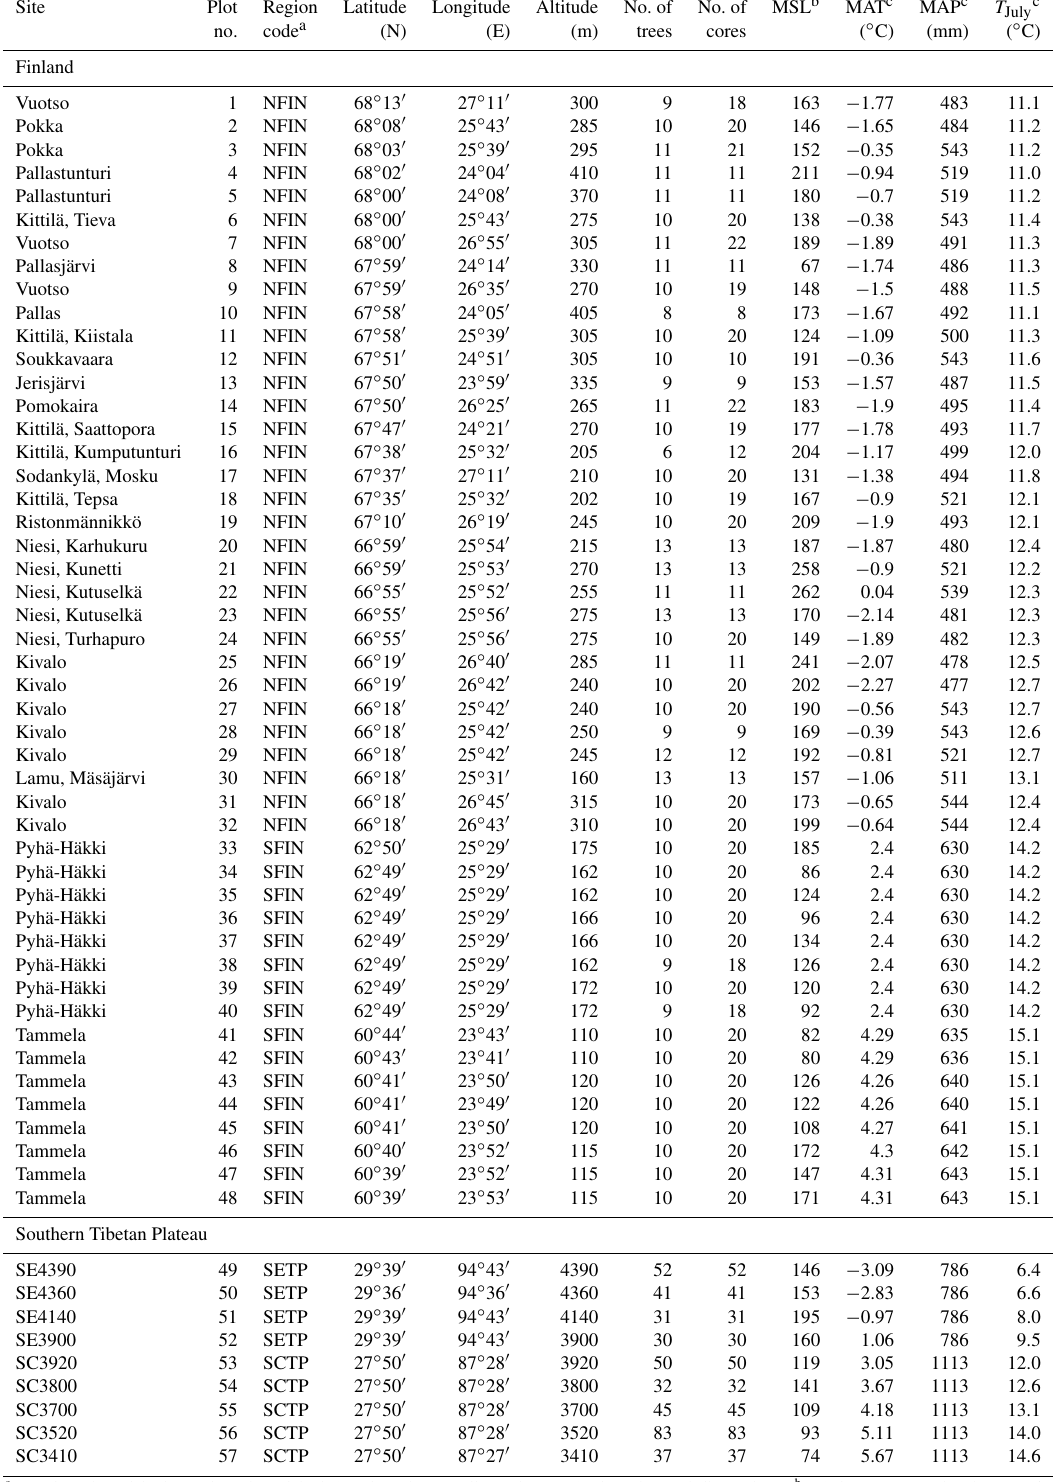
Table 1. Information on the plots, tree-ring samples, and climate conditions along the latitudinal gradient in Finland and the altitudinal gradients on the southern Tibetan